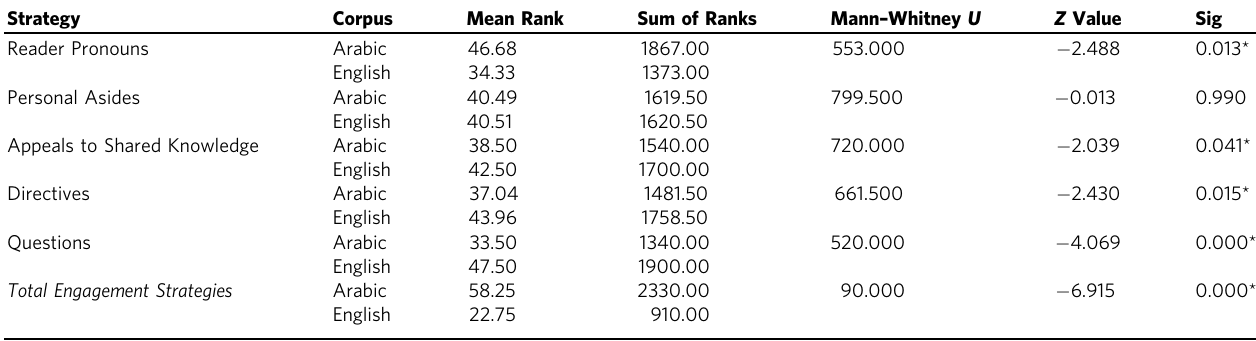
Table 3 The Mann-Whitney U test results.